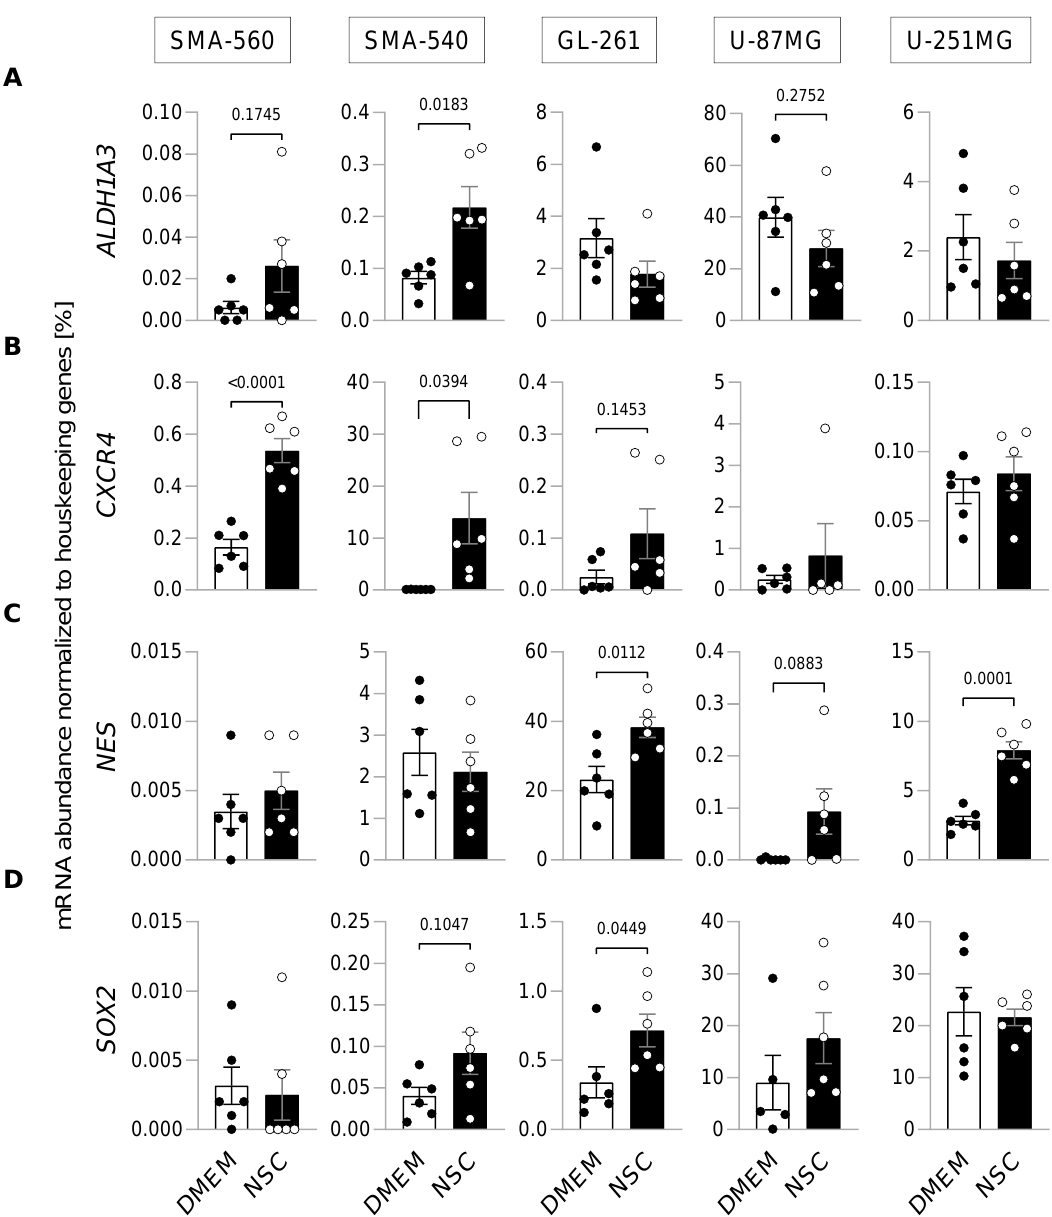
Figure 1. Enrichment of the glioblastoma stem cell fraction. ( A – D ). Culturing murine SMA-560, SMA-540 and GL-261 glioma cells and human U-251MG glioma cells in NSC medium (open circles) increased housekeeper-normalized mRNA abundances of stem cell markers as compared to DMEM medium (closed circles; in addition to the individual values, means ± standard error of three experimental and two observational units each are depicted). The mRNA abundances of four different stem cell markers, ( A ) ALDH1A3 , ( B ) CXCR4 , ( C ) Nestin and ( D ) SOX2 were determined by real-time RT-PCR. Numbers indicate error probability ( p values) as calculated by Welch-corrected two-tailed t